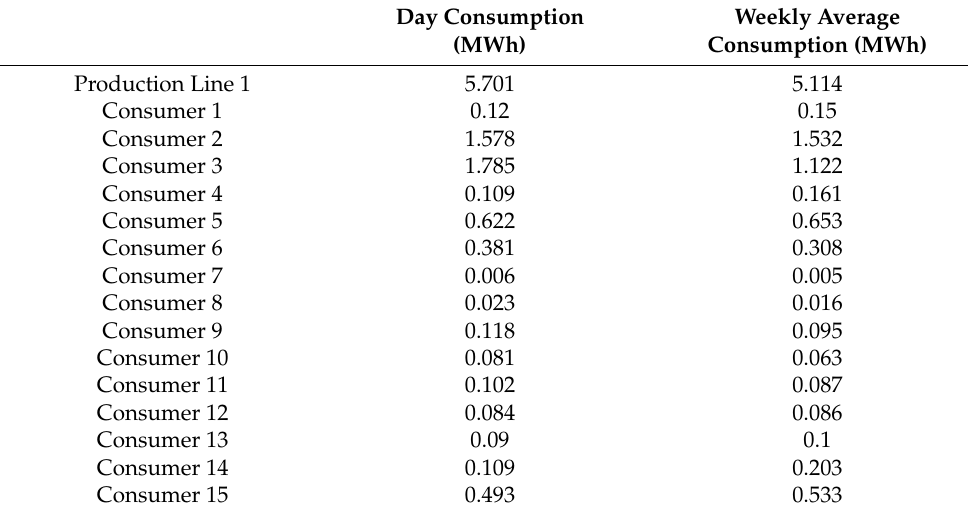
Table 3. Consumer monitoring on Production Line